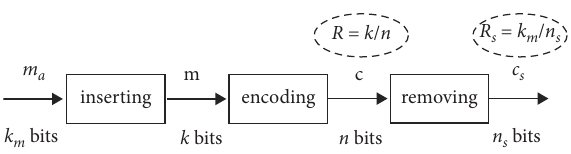
Figure 2: Block diagram of the shortening LDPC encoding.